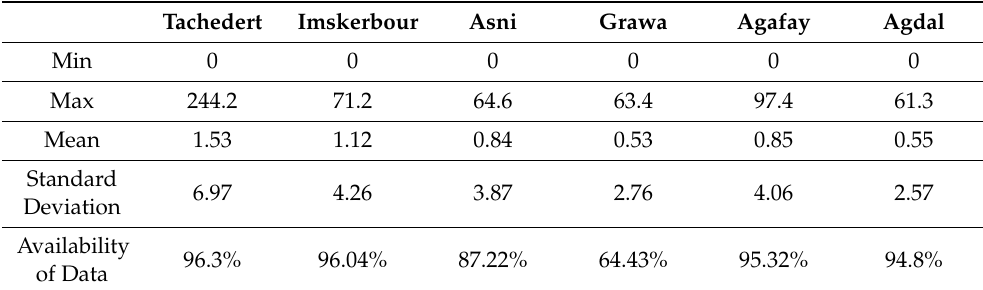
Table 1. Statistical criteria of weather station observations over the period 13 May 2007 to 31 September